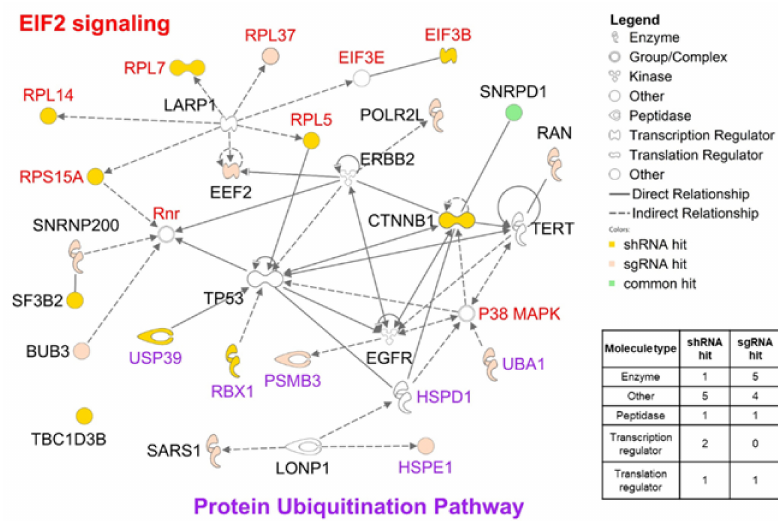
Figure 2. Functional interaction network and molecular classes of the 20 genes with high RNA i e ffi cacy from Figure 1. Red and purple gene names indicate genes involved in ‘EIF2 signaling’ and the ‘Protein Ubiquitination Pathway’, respectively. The network and molecular classes were derived using the Ingenuity Pathway Analysis (IPA)